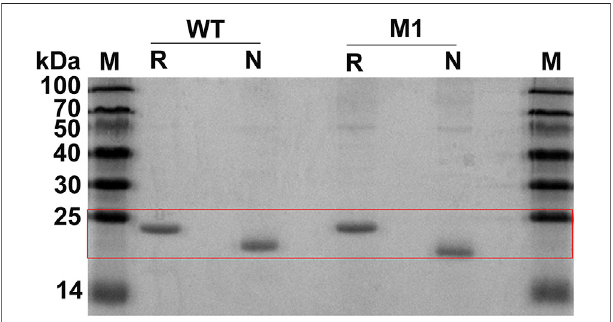
FIGURE 2 | SDS-PAGE analysis of the puri fi ed CjLPMO10A cd (WT) and the mutant M1. M, molecular weight marker; R, reducingconditions withDTT; N, non-reducing conditions without